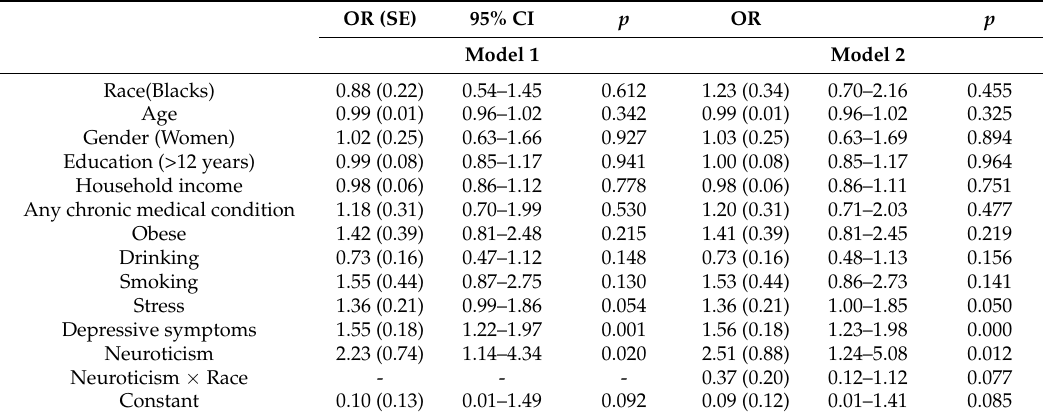
Table 2. Summary of logistic regression models on the association baseline neuroticism and CIDI-based major depressive episode 25 years later based on race ( n = 1219).